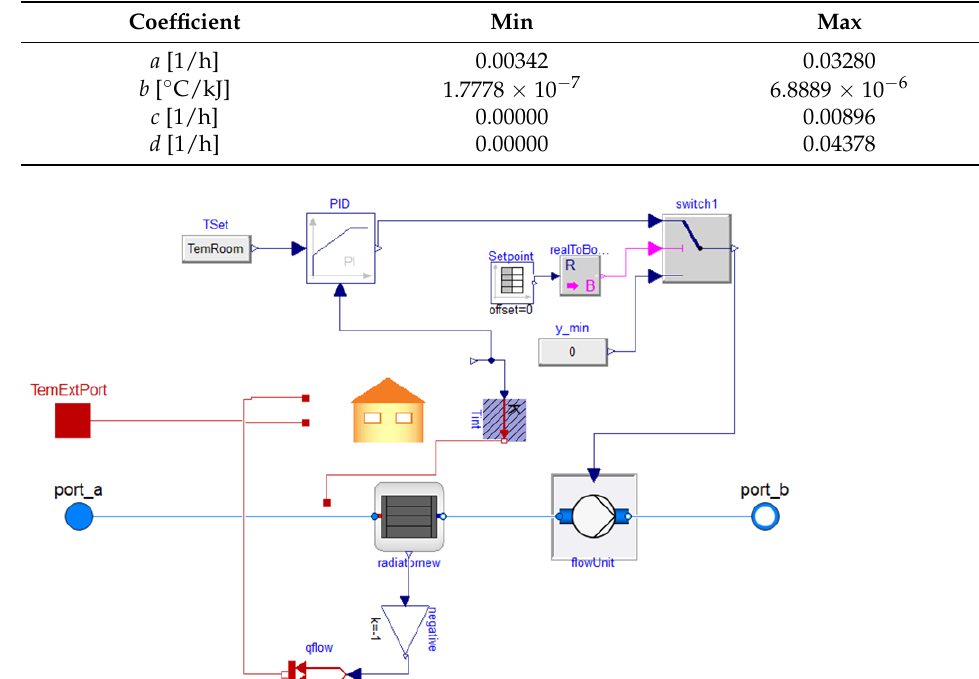
Figure 4. Diagram view of “RCBuilding” model component in Dymola. Table 2. Performance coefficients of buildings supplied by “Nuova Sud” network.